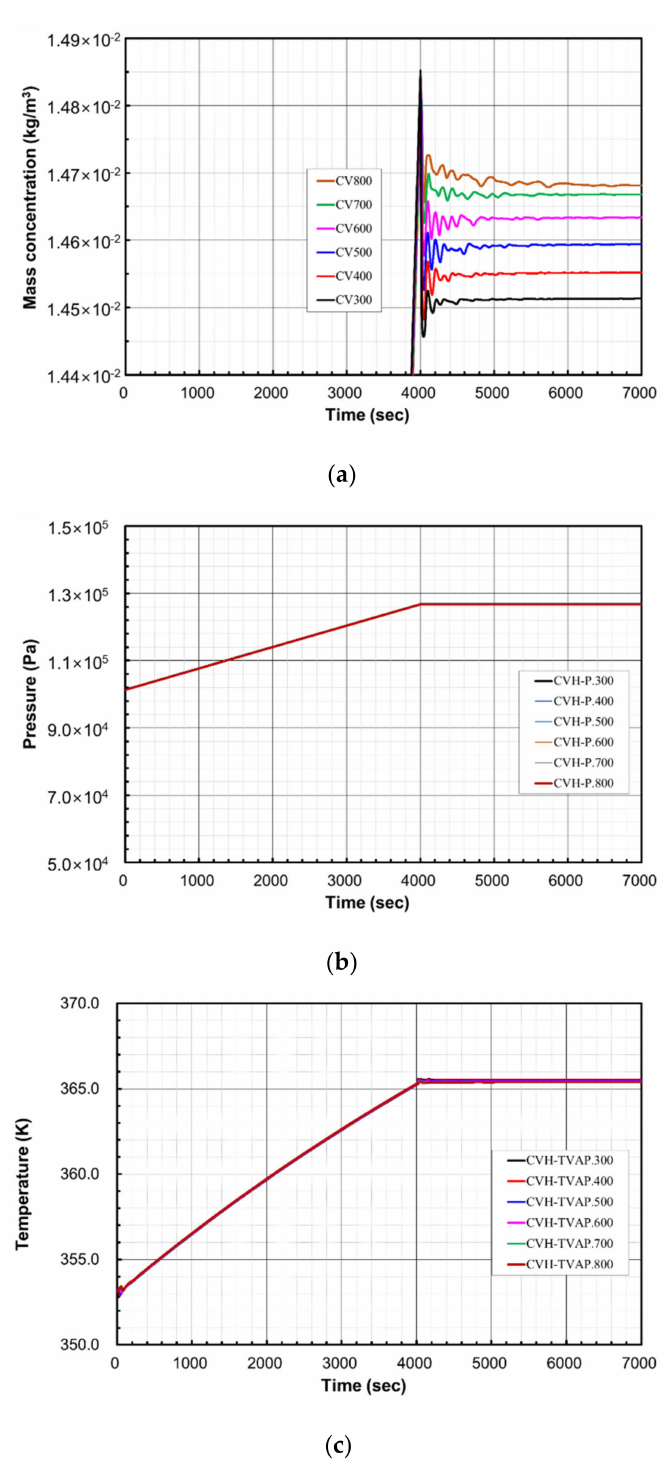
Figure 6. Verification test results by base MELCOR input: ( a ) H 2 mass concentration; ( b ) Gas pressure; ( c ) Gas